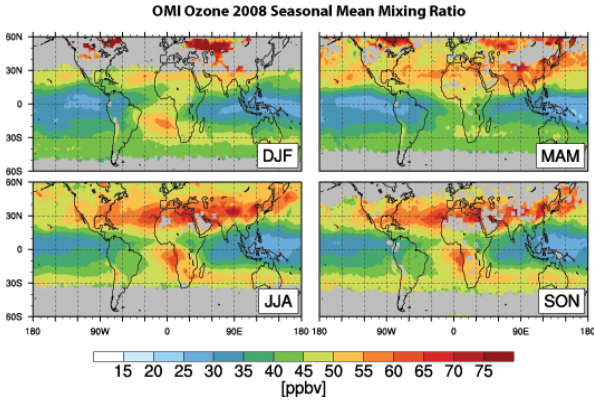
Fig. 1b. Same as Fig. 1a but for OMI ozone mixing ratios at 700– 400hPa.